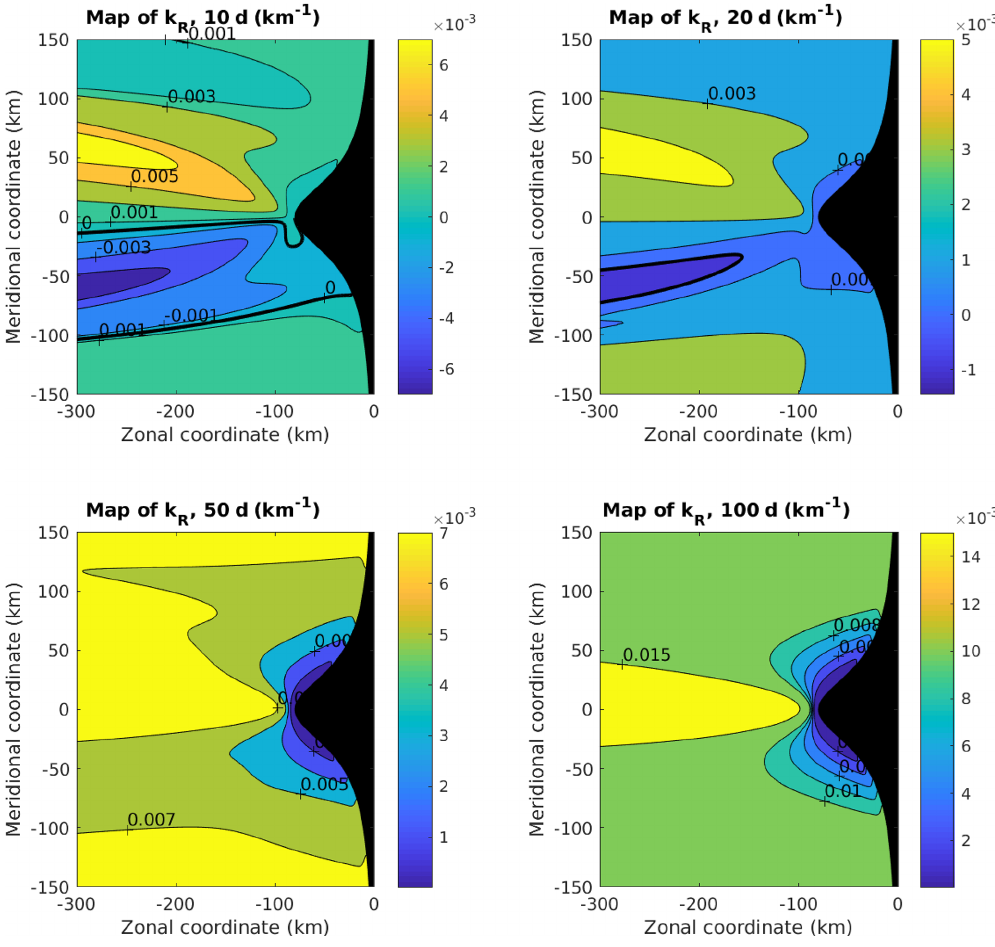
Figure 15. Coefficient k R for periods equal to 10, 20, 50 and 100d. The bold black line separates positive from negative values. Where W R is negative, k R is negative (for periods shorter than 20d, in the area located to the south of the